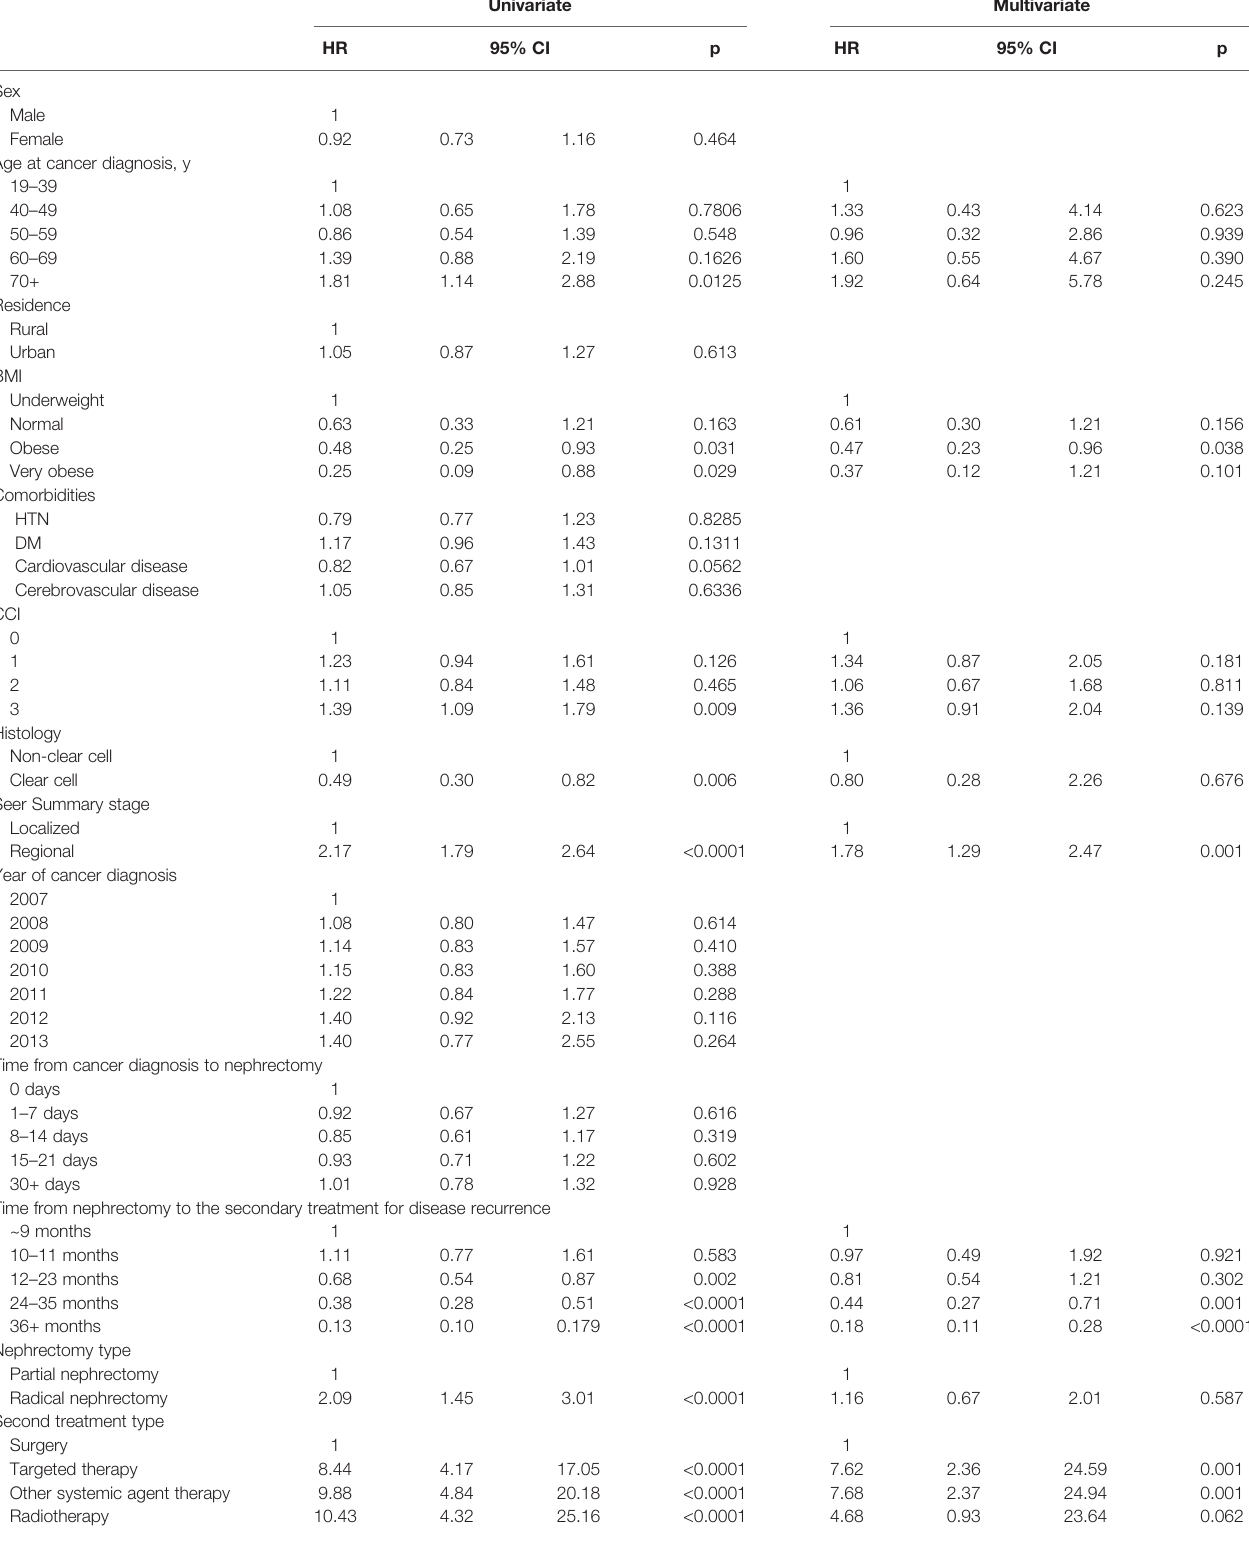
TABLE 3 | Multivariate analysis of overall survival in RCC patients with postoperative disease progression after